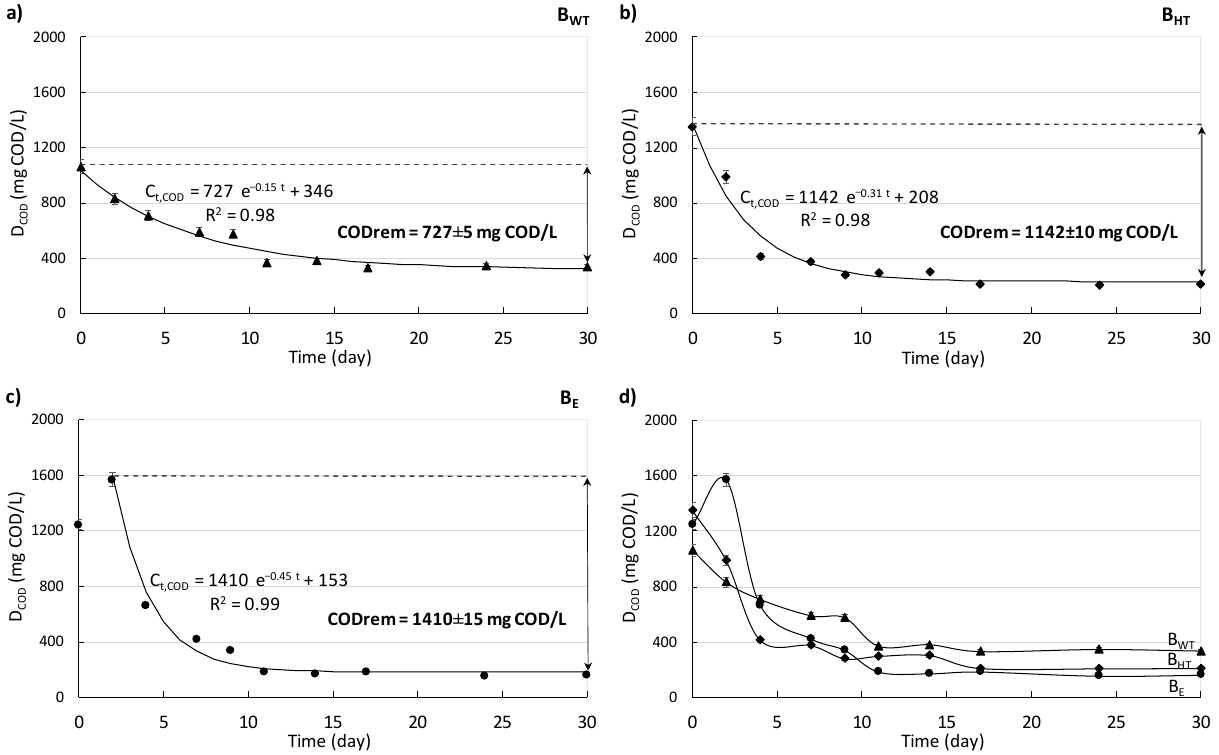
Figure 4. Changes in the D COD concentrations with B WT , B HT , and B E . First ‐ order kinetic models (black lines) for D COD removal are provided on ( a – c) , the changes in D COD concentration from B HT , B E , and B WT ( d ).